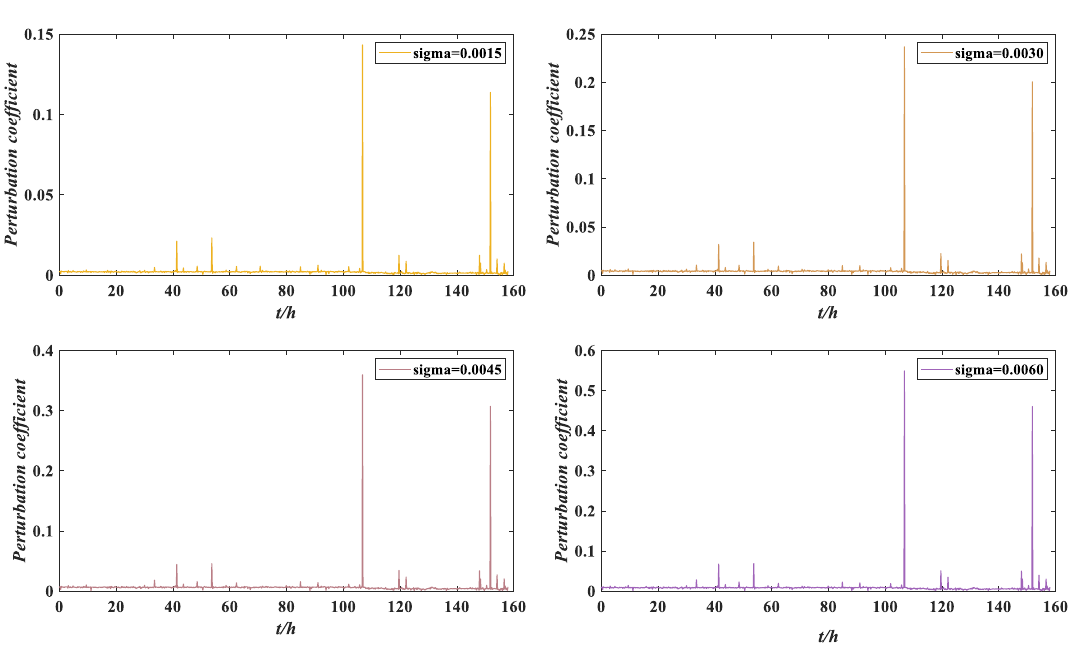
Figure 14. Perturbation coefficients under different perturbation